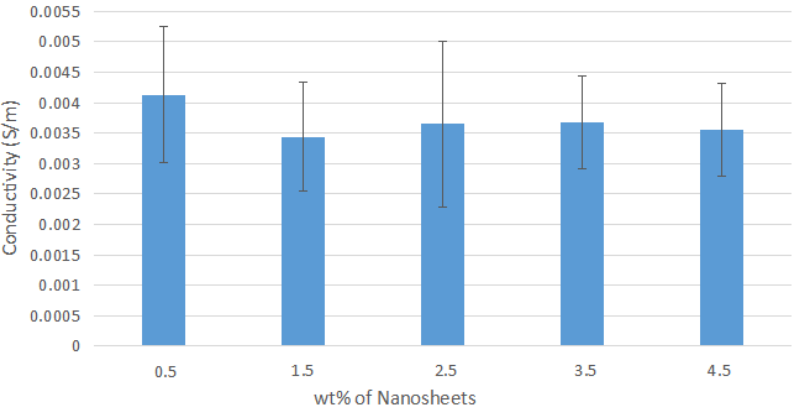
Figure A1. Average Conductivity of Nylon 610 Nanocomposites with Nanosheets Treated at 200 °C and − 0.1 MPa.